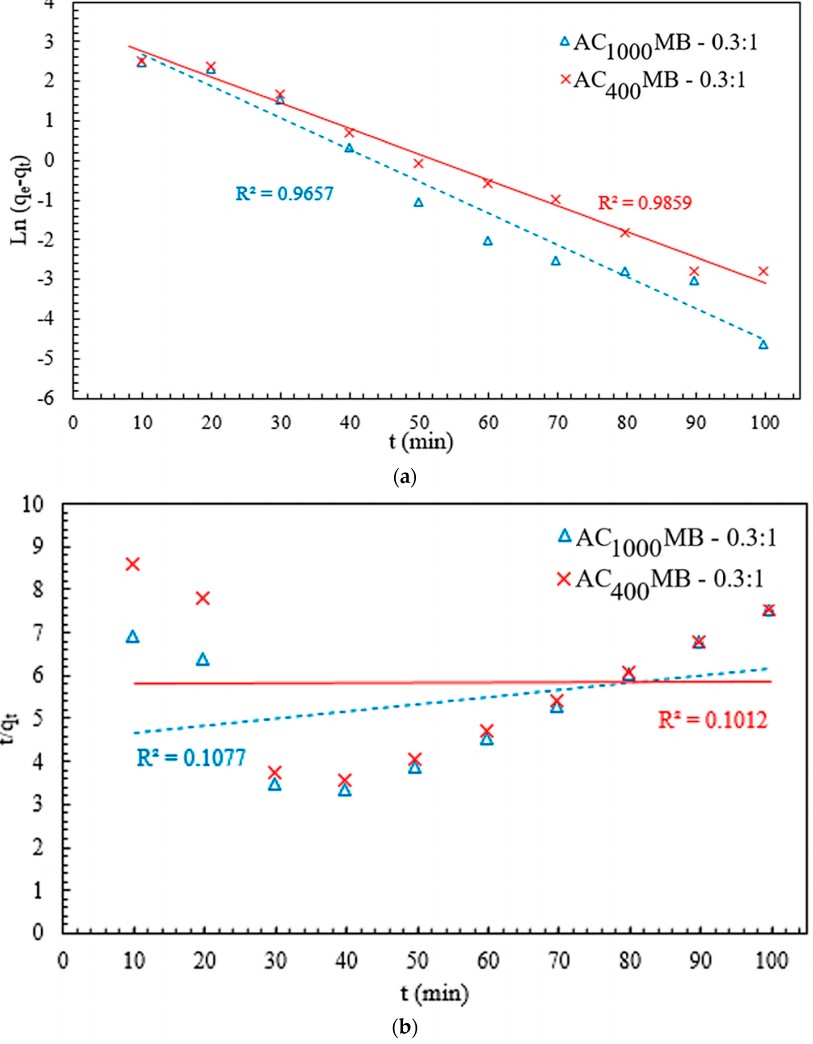
Figure 18. Adsorption kinetic studies: ( a ) pseudo first-order model and ( b ) pseudo second-order